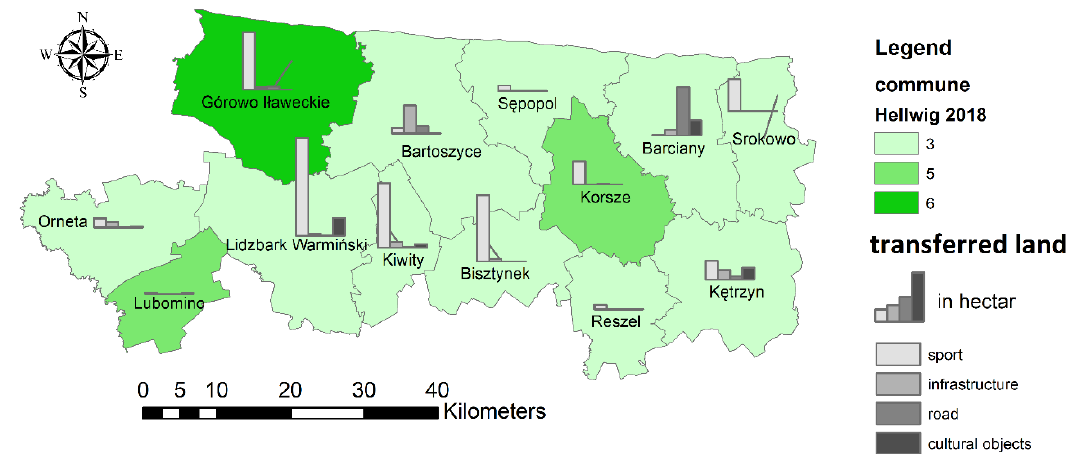
Figure 8. Social development classes for 2018 in comparison with the area of land transferred for various purposes. Data for communes.